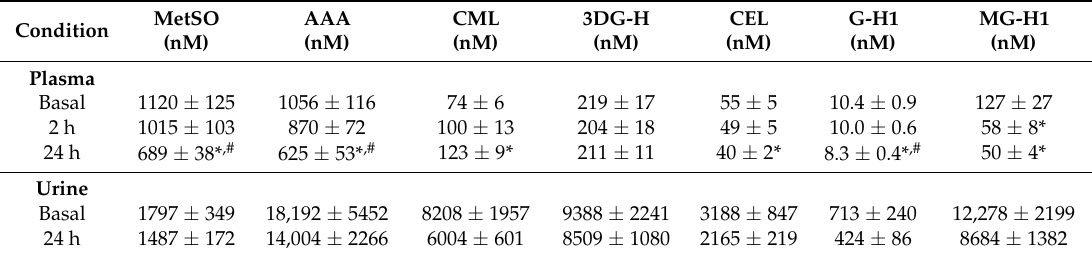
Table 2. Oxidation markers and advanced glycation end product (AGE)-free adduct concentrations in plasma and urine.